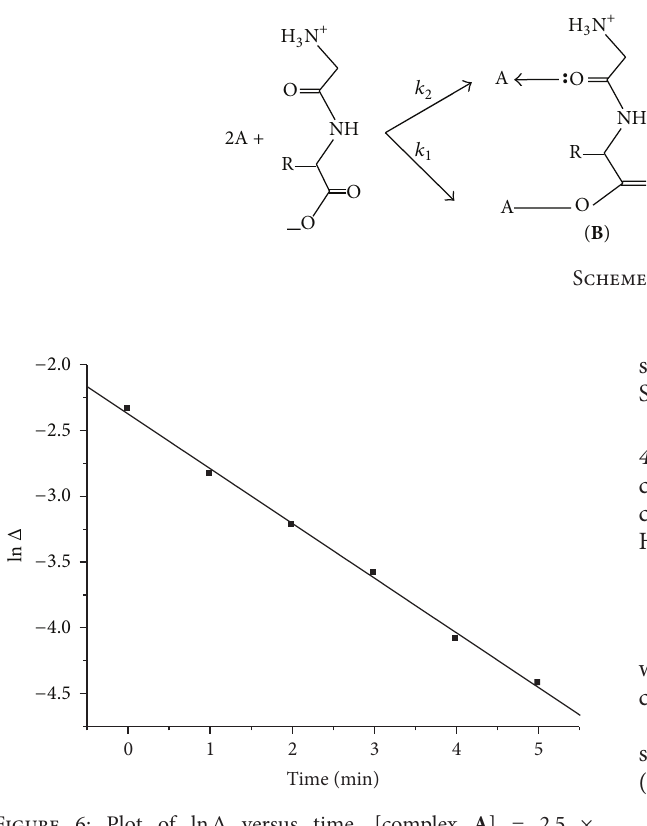
Figure 6: Plot of ln Δ versus time. [complex A ] = 2.5 × 10 −4 moldm −3 , [ L 1 -L 󸀠 H ] = 7.5 × 10 −3 moldm −3 , pH = 4.3, and temperature = 60 ∘